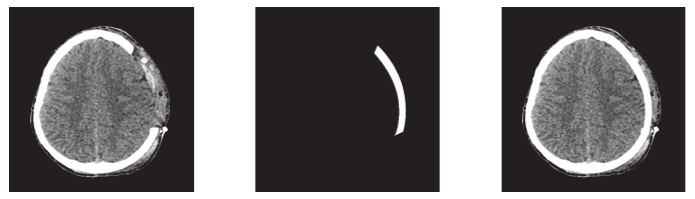
Figure 7. Construction of fractured part using GC 2 rational Ball curves.